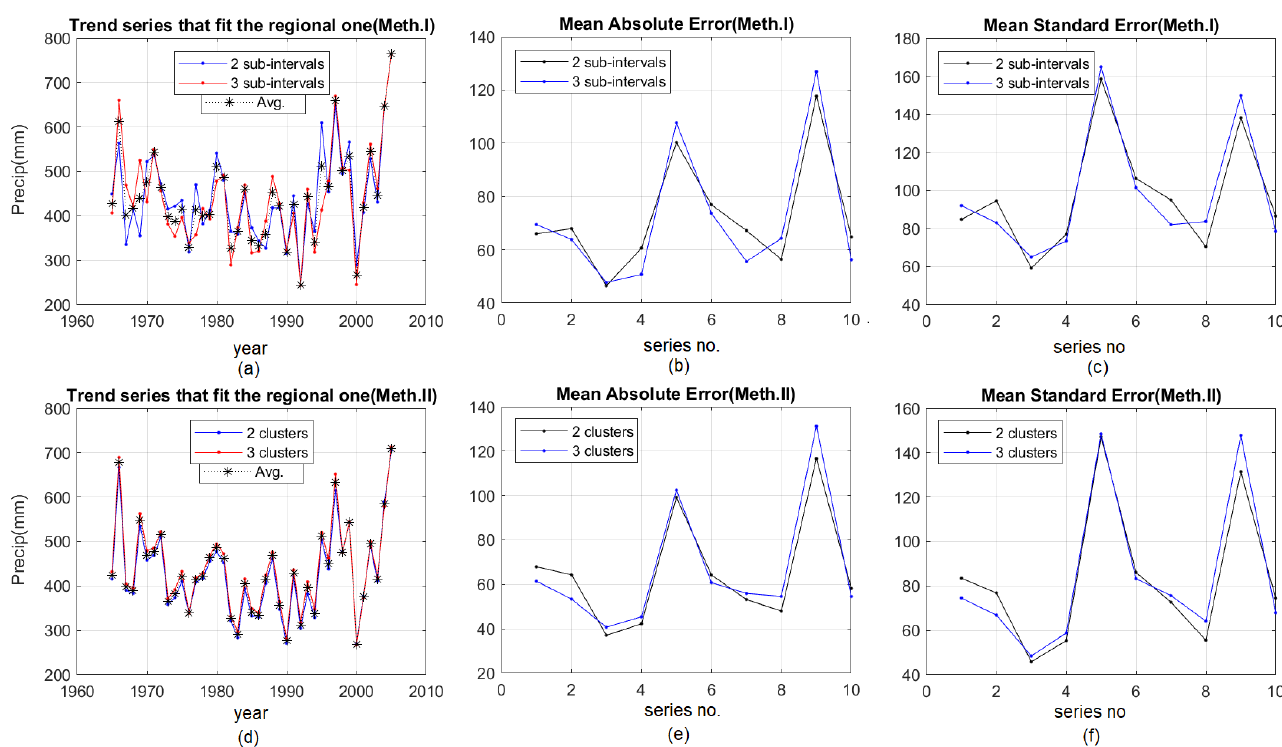
Figure 11. Comparative results when using three intervals/clusters ( a ) “Trend series that fit the regional one” in Method I; ( b ) MAE in Method I; ( c ) MSE in Method I; ( d ) “Trend series that fit the regional one” in Method II; ( e ) MAE in Method II; ( f ) MSE in Method II The average MAE = 65.10, corresponding to MPPM (Method II), is the lowest com- Table 4. Comparison of the performances of Method II, IDW and pared to the average MAEs corresponding to IDW and kriging (KG), 71.11 and 84.40, respectively. For six out of 10 stations, MAEs computed in Method II are lower than those corresponding to IDW and KG. MAEs in IDW (KG) are the lowest for three (one) stations.